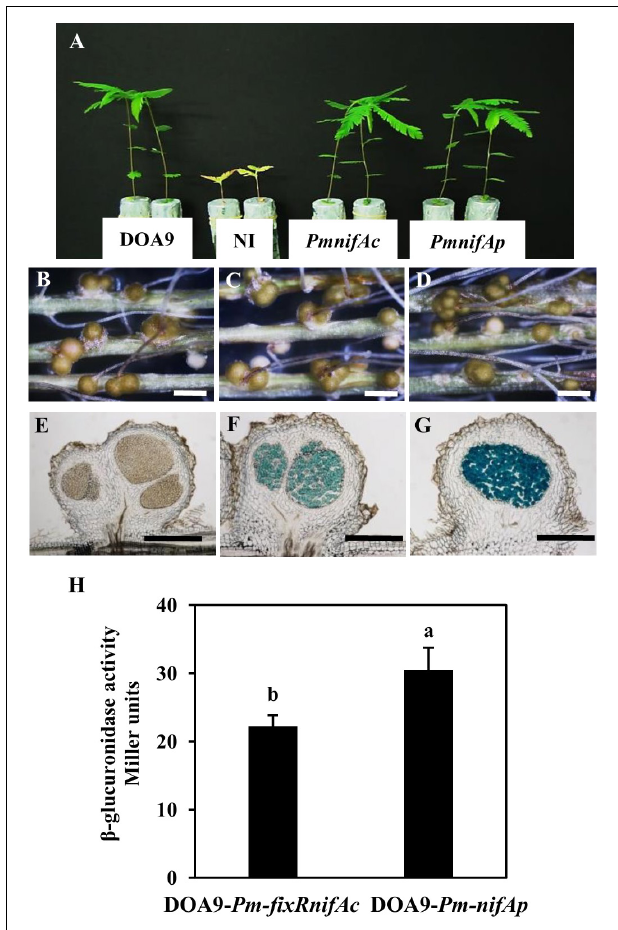
FIGURE 2 | The two nifA genes of Bradyrhizobium sp. DOA9 strain are expressed during symbiosis with Aeschynomene americana . (A) Comparison of growth of plants (aerial part) non-inoculated (NI) or inoculated with WT and reporter strains DOA9- Pm-fixRnifAc and DOA9- Pm - nifAp (at 14 dpi). (B–D) Root nodules observed with a stereomicroscope stereomicroscope. (B) Nodules elicited by WT; (C) Nodules elicited by DOA9- Pm-fixRnifAc ; (D) Nodules elicited by DOA9- Pm - nifAp . (E–G) Expression of gusA reporter gene revealed on 40 µ m nodule sections stained with X-Gluc. Nodules elicited by WT (E) , DOA9- Pm-fixRnifAc (F) and DOA9- Pm-nifAp (G) . Scale bars are 1 mm for (B–D) and 250 µ m (E–G) . (H) , β -glucuronidase activity of DOA9- Pm-fixRnifAc and DOA9- Pm-nifAp reporter strains grown after 7 days of culture under free-living conditions (microaerobiosis and not combined nitrogen source). Different letters above error bars indicate significant differences at P < 0.05 (Tukey’s HSD test).